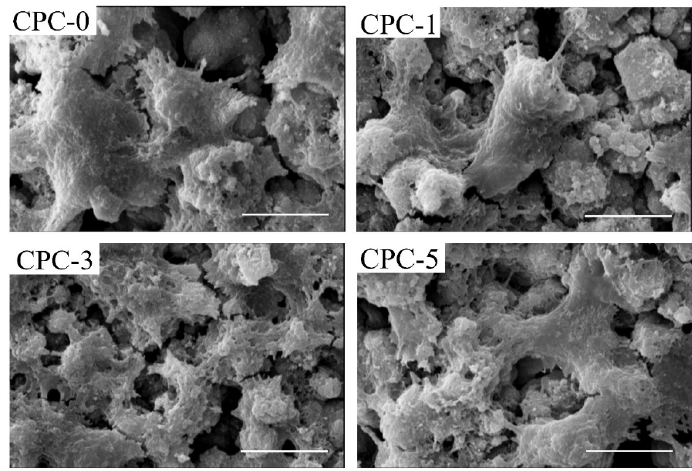
Figure 6. SEM images of the initial attachment of MC3T3-E1 cells on the cement samples. The scale bar is 10 µm.